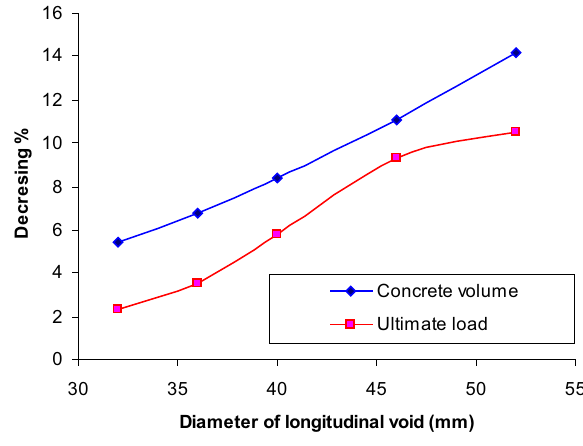
Fig. 8 Decreasing in ultimate load and concrete volume with differ- ent longitudinal